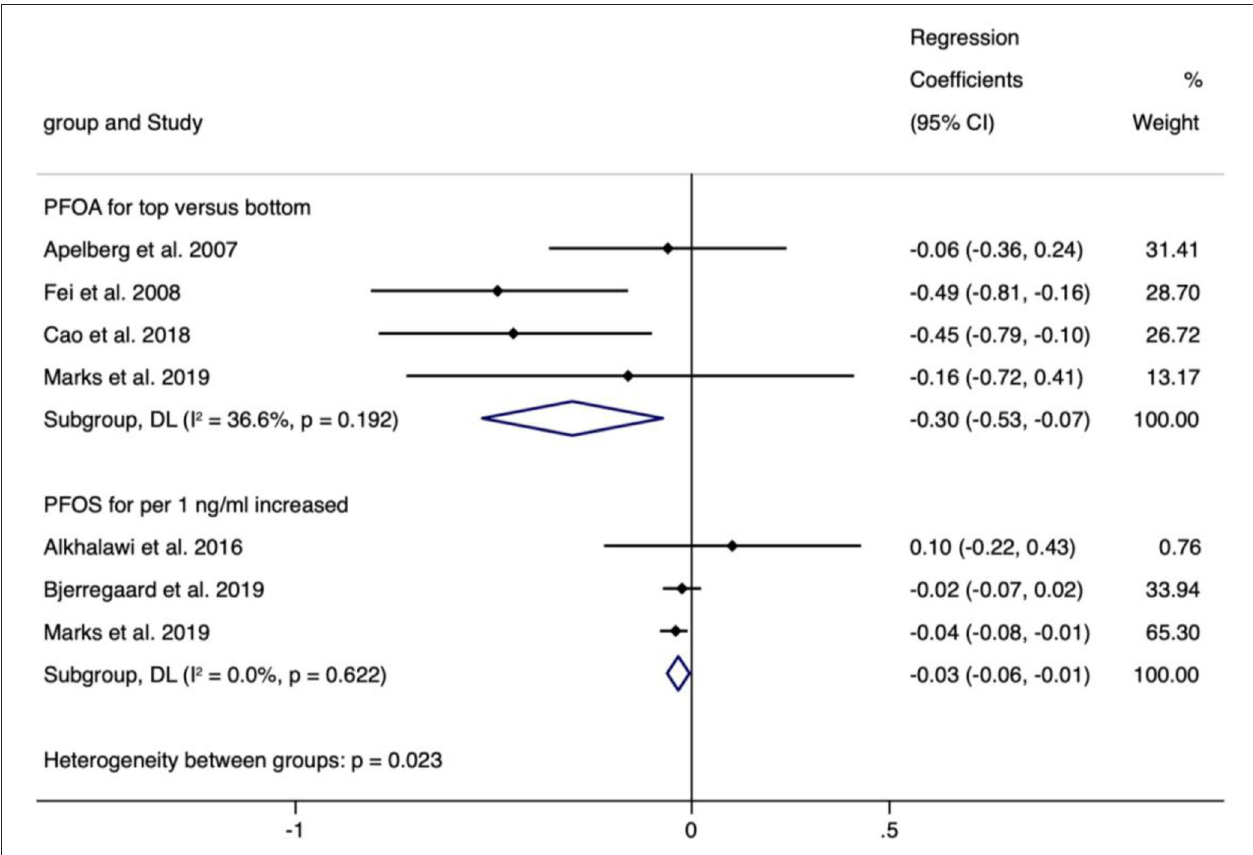
FIGURE 5 | Meta-analysis of the association of PFOS and PFOA with birth length